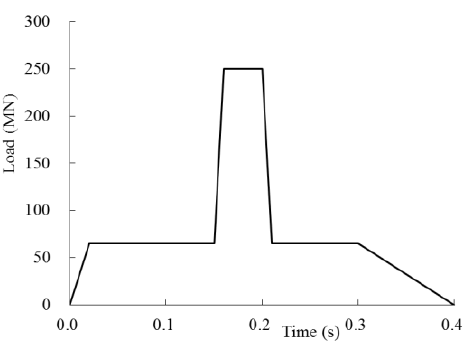
Figure 2. The impact pressure time-history function of fuselage and wing [22].